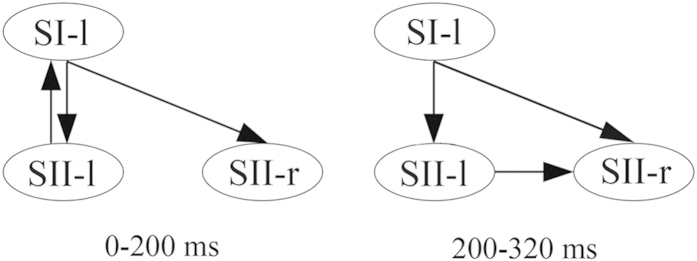
Graph obtained from rPDC analysis applied to source time series located at SI-l, SII-l and SII-r for somatosensory evoked MEG.